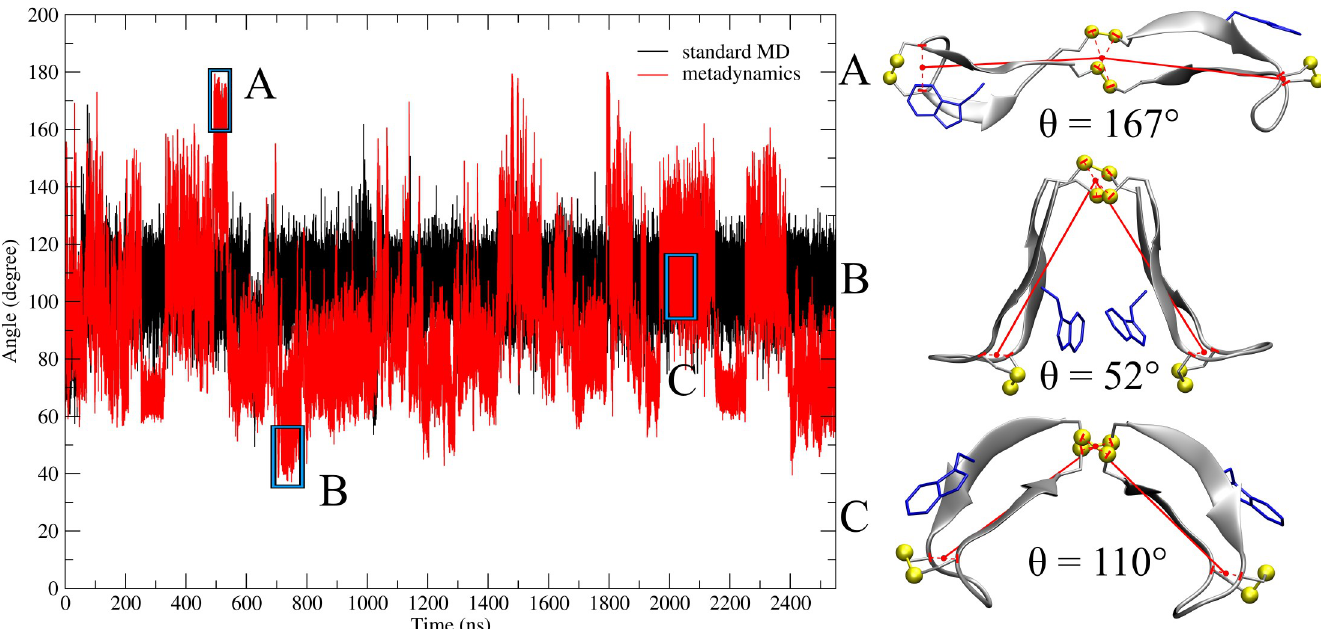
Fig 4. Hinge type motion described by the opening angle. Opening angle representation by taking the geometric center between C5/8 and C5’/8’, respectively. The midpoint was built as the geometric center between the four sulfur atoms forming the disulfide cluster. The opening angle evolution during the standard MD simulation is depicted in black and metadynamics in red. Highlighted area A shows the maximum opening angle, area B, the minimum and area C, an averaged opening angle. The structural representation for each area is presented on the right.